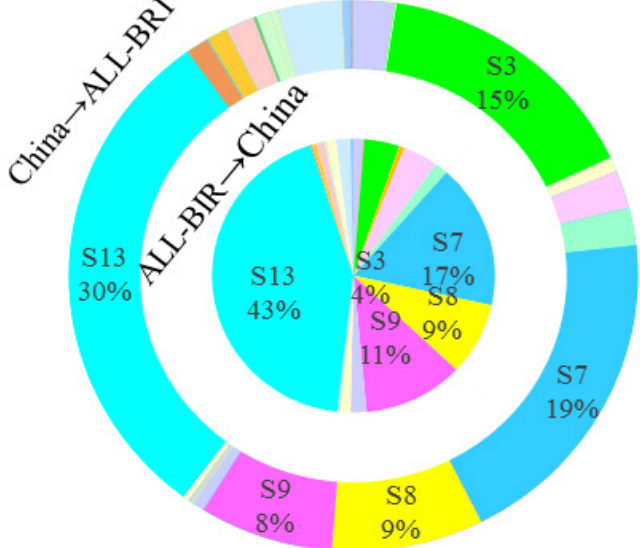
Figure 3. Sectoral CSE between China and ALL-BRI.